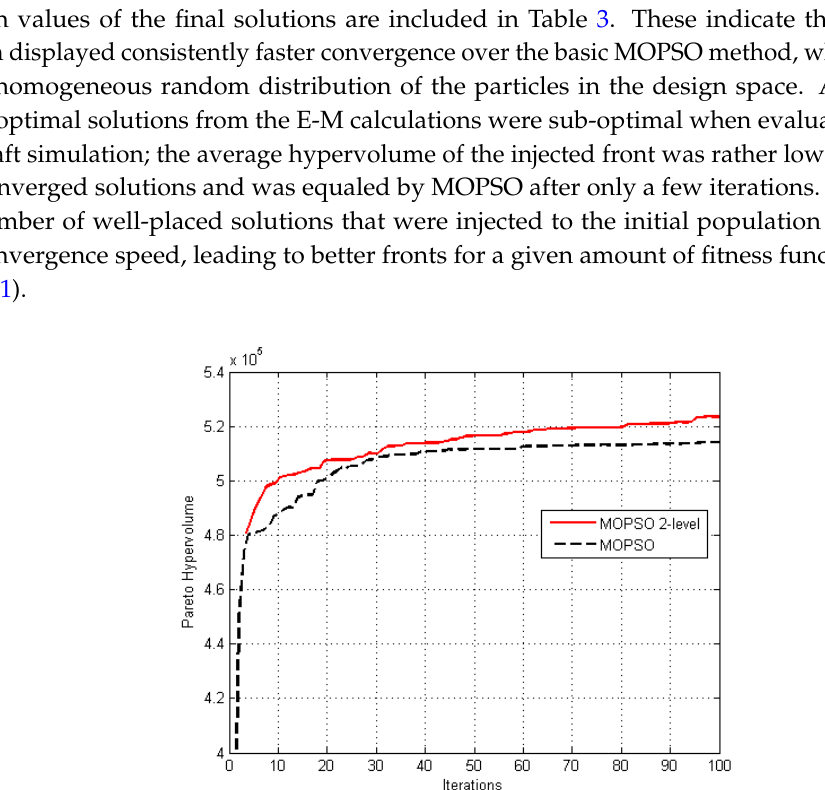
Figure 9. Flowchart of the proposed two-level optimization scheme.